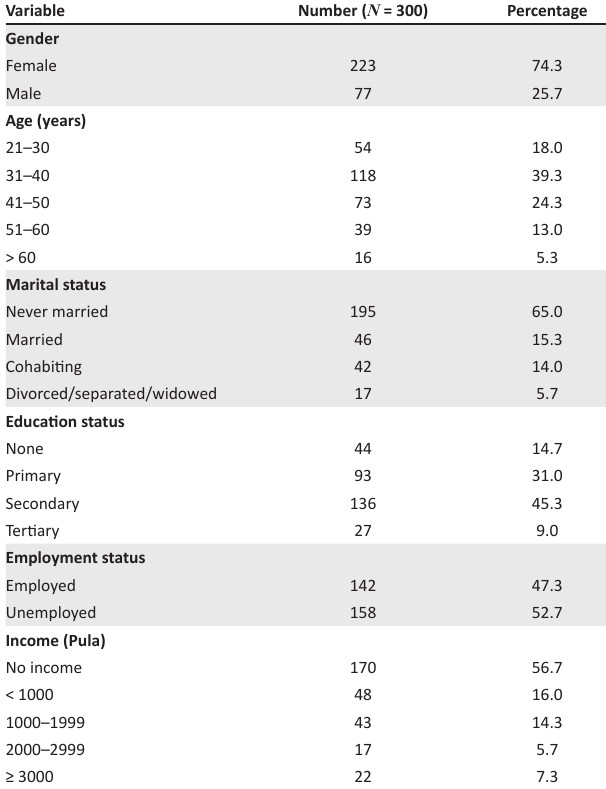
TABLE 1: Sociodemographic characteristics of the respondents ( N =